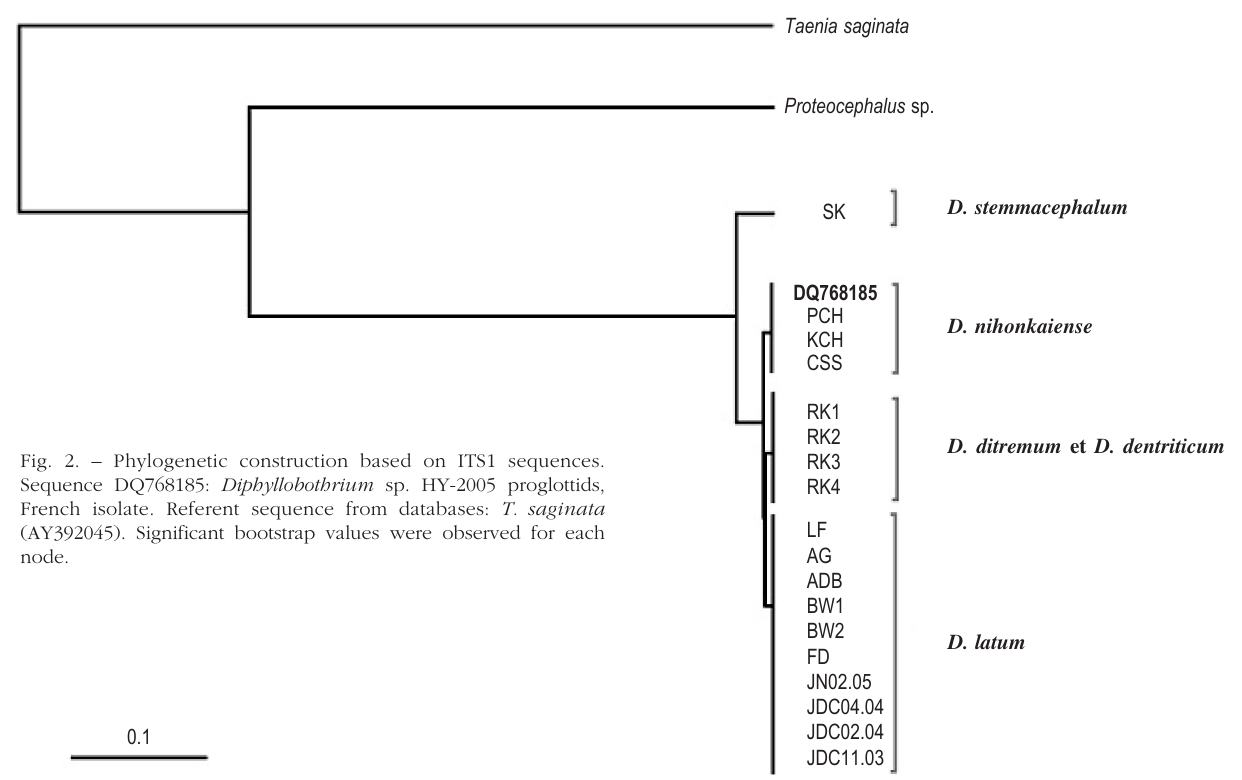
Fig. 2. – Phylogenetic construction based on ITS1 sequences. Sequence DQ768185: Diphyllobothrium sp. HY-2005 proglottids, French isolate. Referent sequence from databases: T. saginata (AY392045). Significant bootstrap values were observed for each